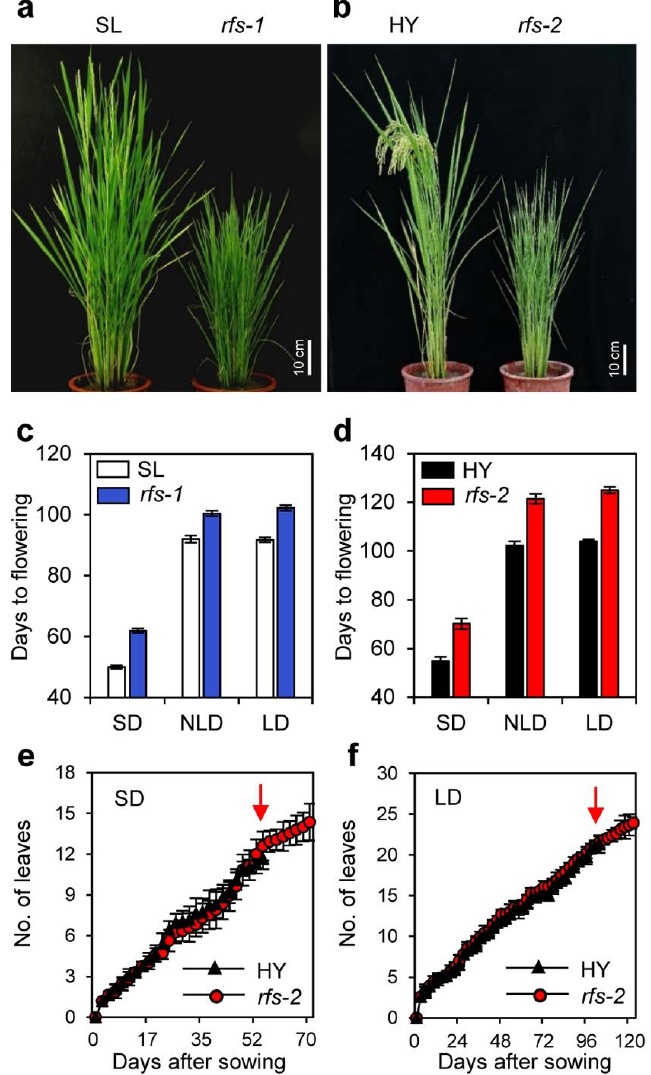
Figure 1. Mutation of RFS results in delayed rice flowering independent of the photoperiod. ( a , b ) Flowering phenotypes of the rfs-1 ( a ) and rfs-2 ( b ) mutants were compared with their parental japonica cultivars ‘Seolak’ (SL), and ‘Hwayoung’ (HY), respectively. Rice plants were grown in the paddy field under natural long-day (NLD) (~14 h light/day) conditions until the parental lines flowered. White scale bars = 10 cm. ( c , d ) Days to flowering of the rfs-1 ( c ) and rfs-2 ( d ) mutants and their parental lines (SL and HY) were determined in short-day (SD) (10 h light/day), NLD, and long-day (LD) (14.5 h light/day) conditions. ( e , f ) Comparison of leaf emergence rates between HY and rfs-2 plants under SD ( e ) and LD ( f ) conditions during plant development. The leaf emergence rate was scored according to the method of Itoh et al. (1998). Red arrows indicate the average flowering date of HY. Means and standard deviations were obtained from 20 plants ( c , d ) and 10 plants ( e , f ) of each genotype. To further confirm whether mutation of RFS delays rice flowering, we observed the flowering time of the rfs-2 knockout mutant, which harbors a T-DNA fragment in the